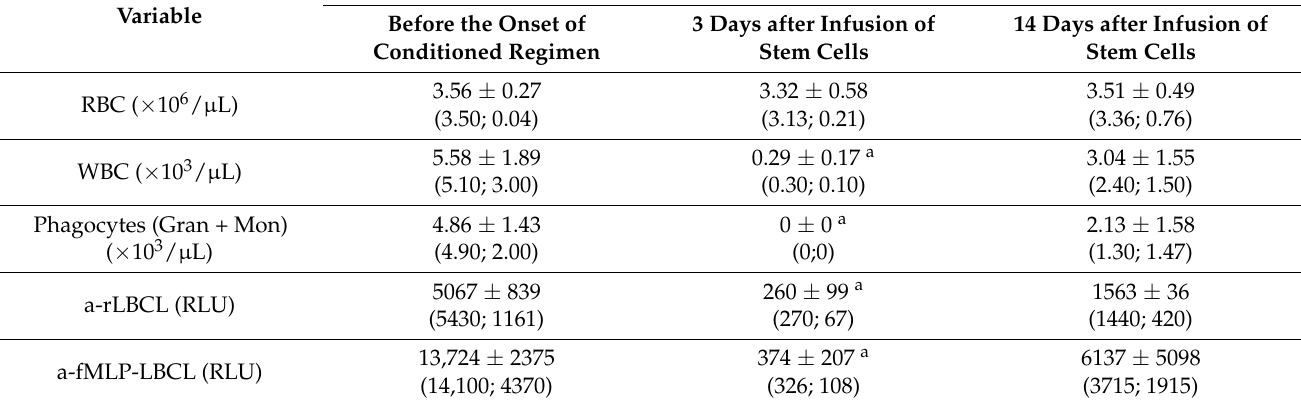
Table 6. Great suppression of a-rLBCL and a-fMLP-LBCL in patients with blood malignancy who after conditioned regimen had no detectable phagocytes (granulocytes and monocytes) in circulating